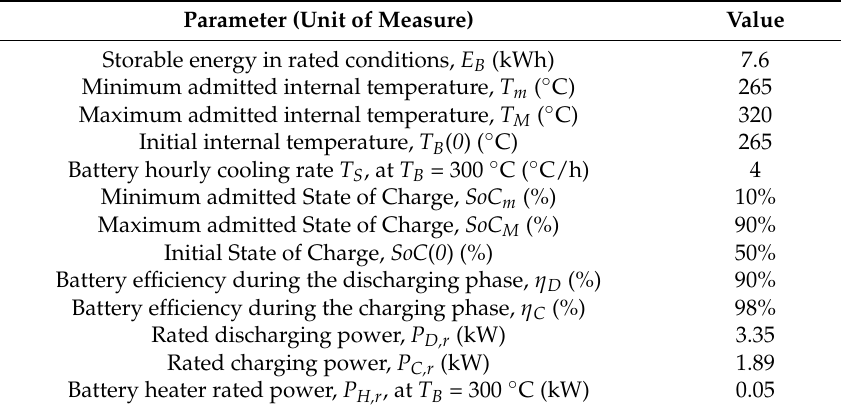
Table 5. Rated characteristics of the NaNiCl 2 -based BESS considered in the case study. Parameter (Unit of